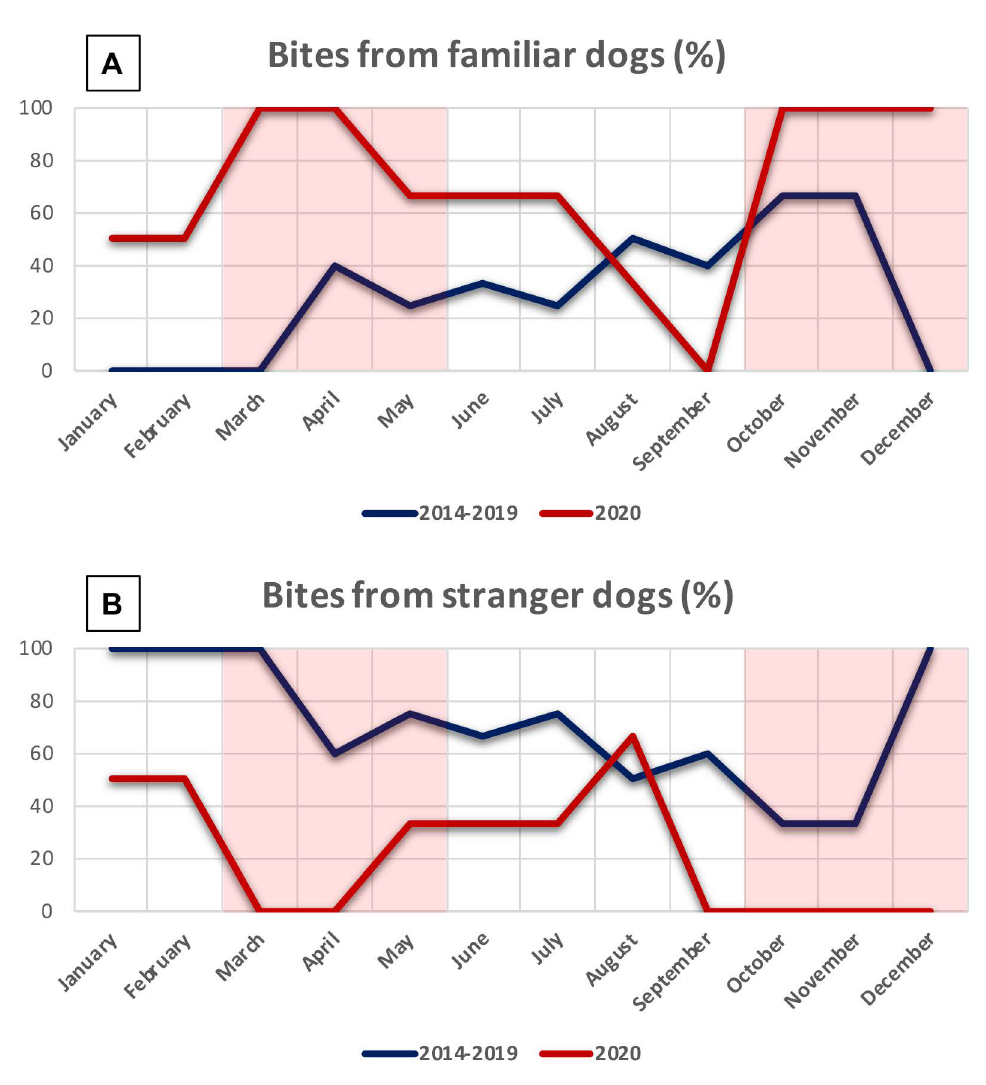
Figure 3. Relative numbers of dog bites/months. The red areas represent the two Italian lockdown periods. ( A ) Bites from familiar dogs. ( B ) Bites from stranger